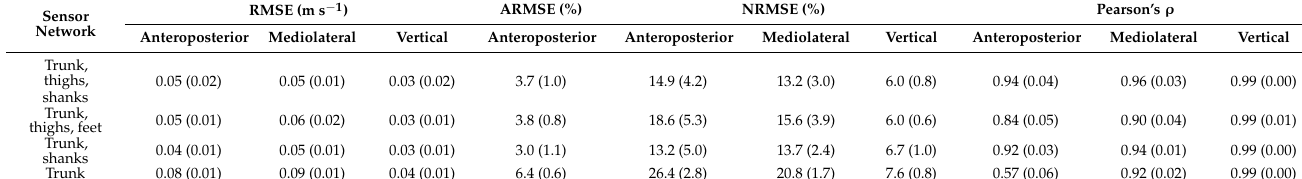
Table 4. Accuracy of body center of mass (BCoM) velocity derived from the sensor-network-based BCoM acceleration compared to the reference velocity computed from optical motion capture in terms of root mean square error (RMSE), RMSE normalized to average walking speed (ARMSE) and peak-to-peak normalized RMSE (NRMSE).